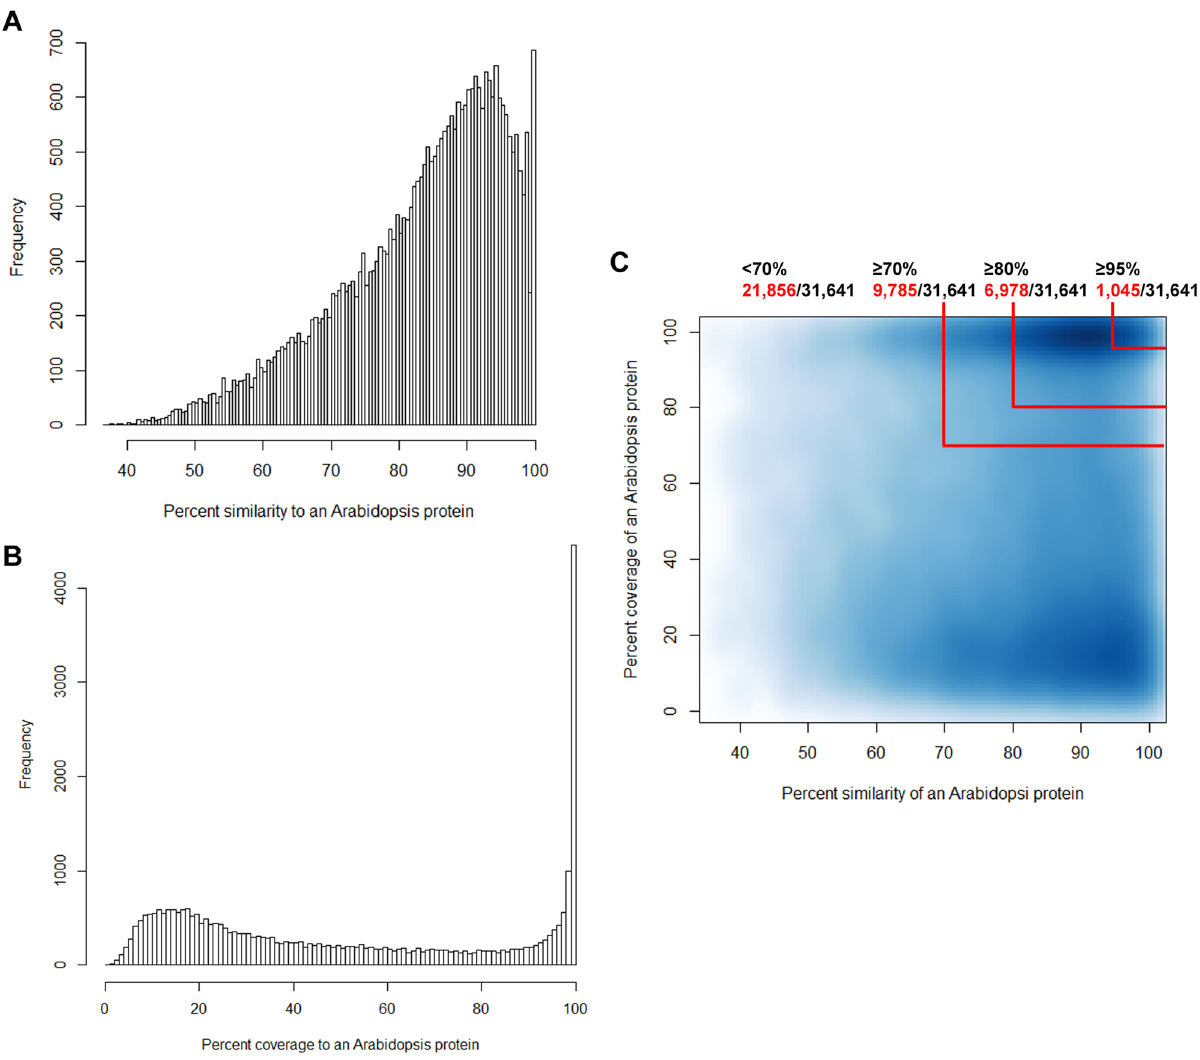
Fig 2. Results of comparative trancriptome analyses between B . humilis unigenes and A . thaliana proteins. (A) Frequency of protein identity values for B . humilis unigenesversus A . thaliana proteins. (B) Frequencyof the percentage coverage of each B . humilis unigeneversus corresponding A . thaliana protein. Percentagecoveragewas calculatedby dividingprotein length by longestpositive hit. (C) Smoothed color density map. The percentage similarity (A) and coverage (B) for each B . humilis unigeneversus an A . thaliana protein were plotted using the ‘smoothScatter’ packagein R [17]. B . humilis unigeneswith 70%, 80%, and 95% sequenceidentity and coverage are shown with red lines, and all statistical analyseswere performed followingthe protocol in Dorn et al. [2].